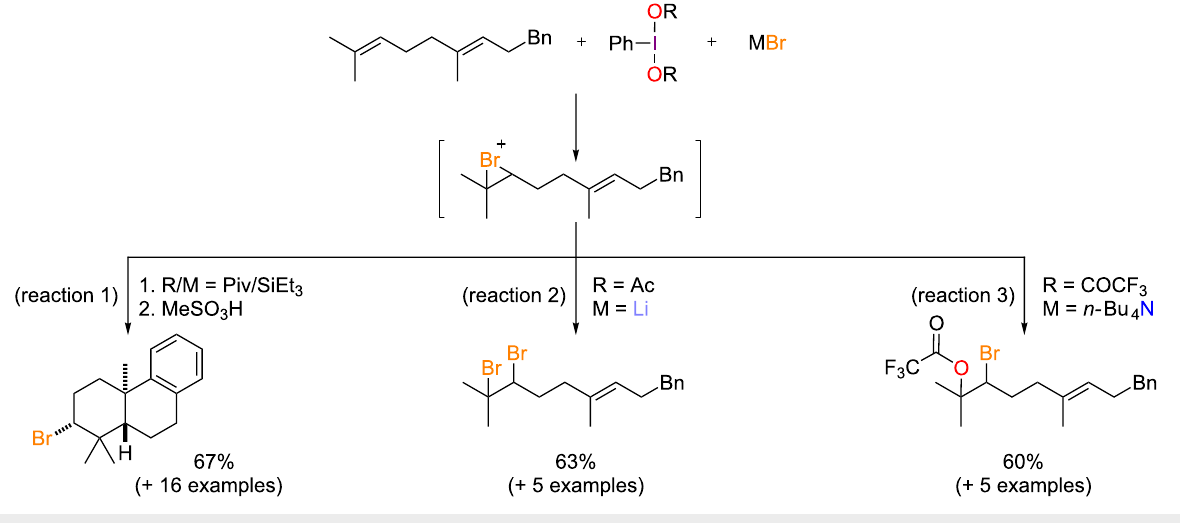
Scheme 1: Previously developed bromo-functionalizations of polyprenoids using iodine(III) reagents.